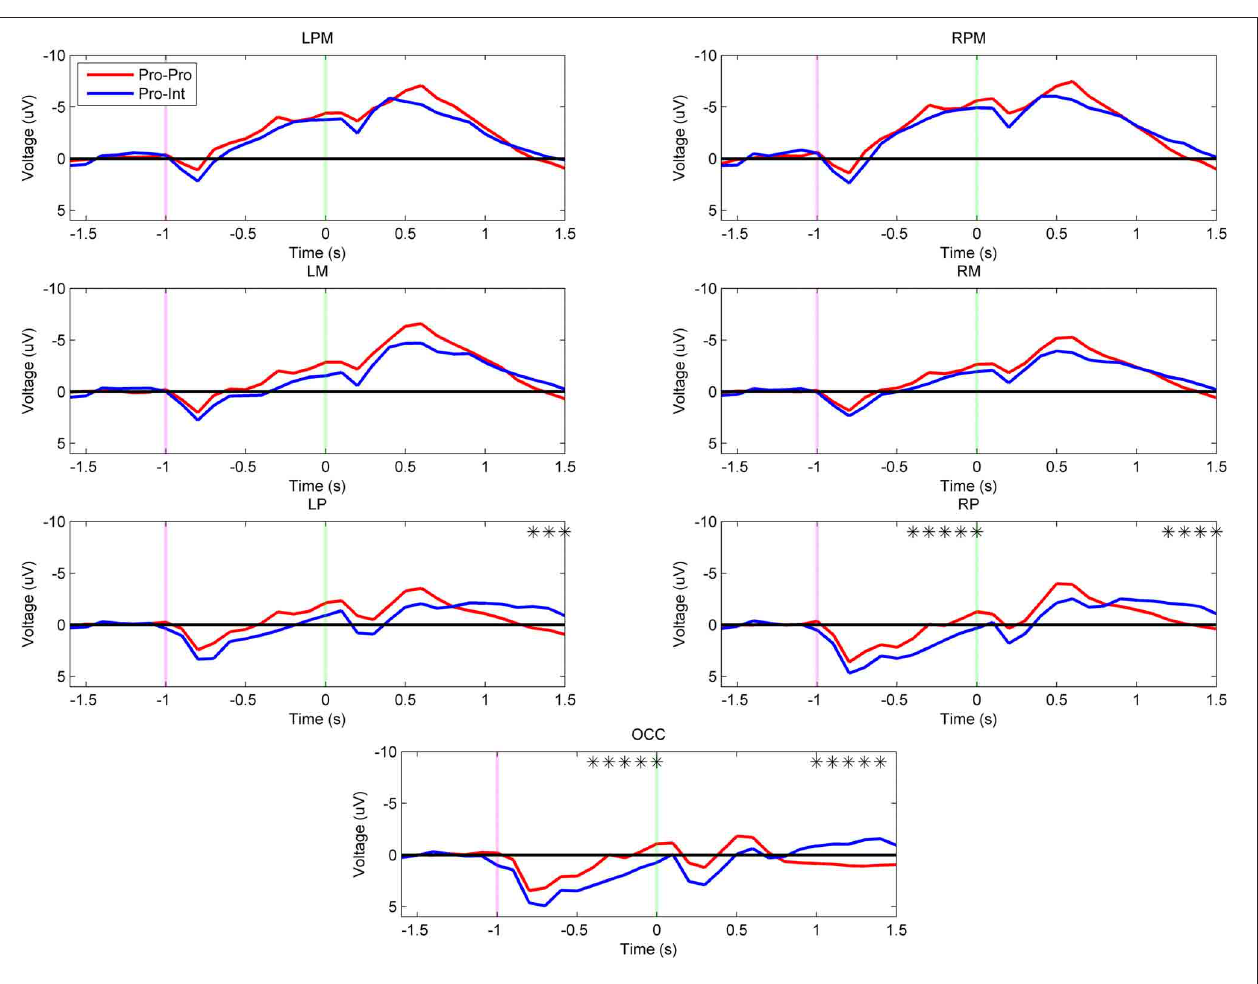
FIGURE 4 | Grand-averaged region-level voltage plots for the Pro–Pro (red) and Pro–Int (blue) groups. The planning cue is marked with a pink dotted line at –1.0s and the execution cue is marked